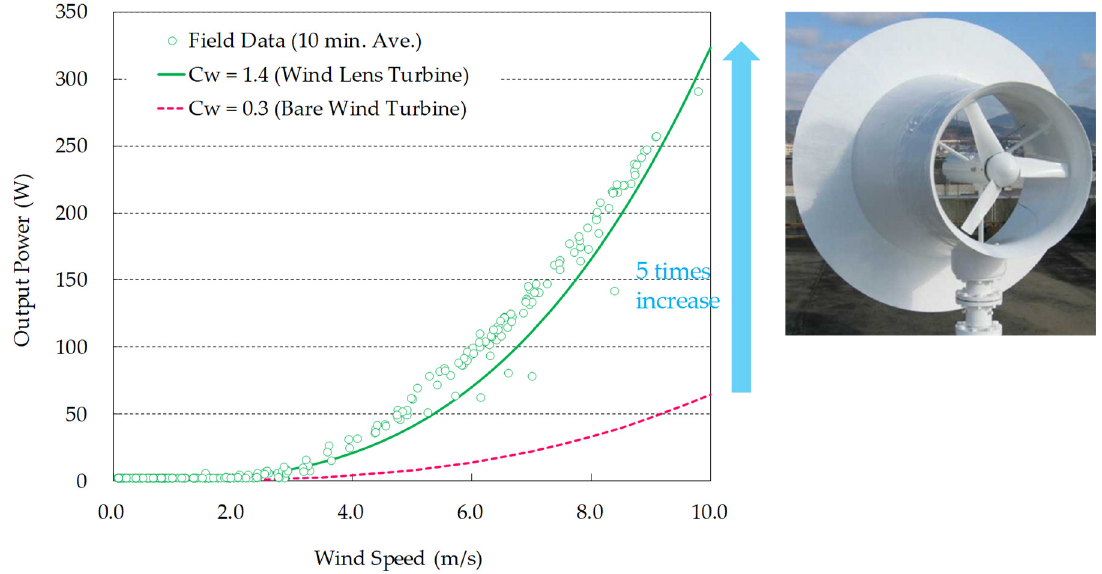
Figure 2. Field experiment of a 500 W wind lens turbine (WLT) with a long brimmed diffuser, a rotor diameter of 0.7 m, and a lens diameter of 1.8 m.